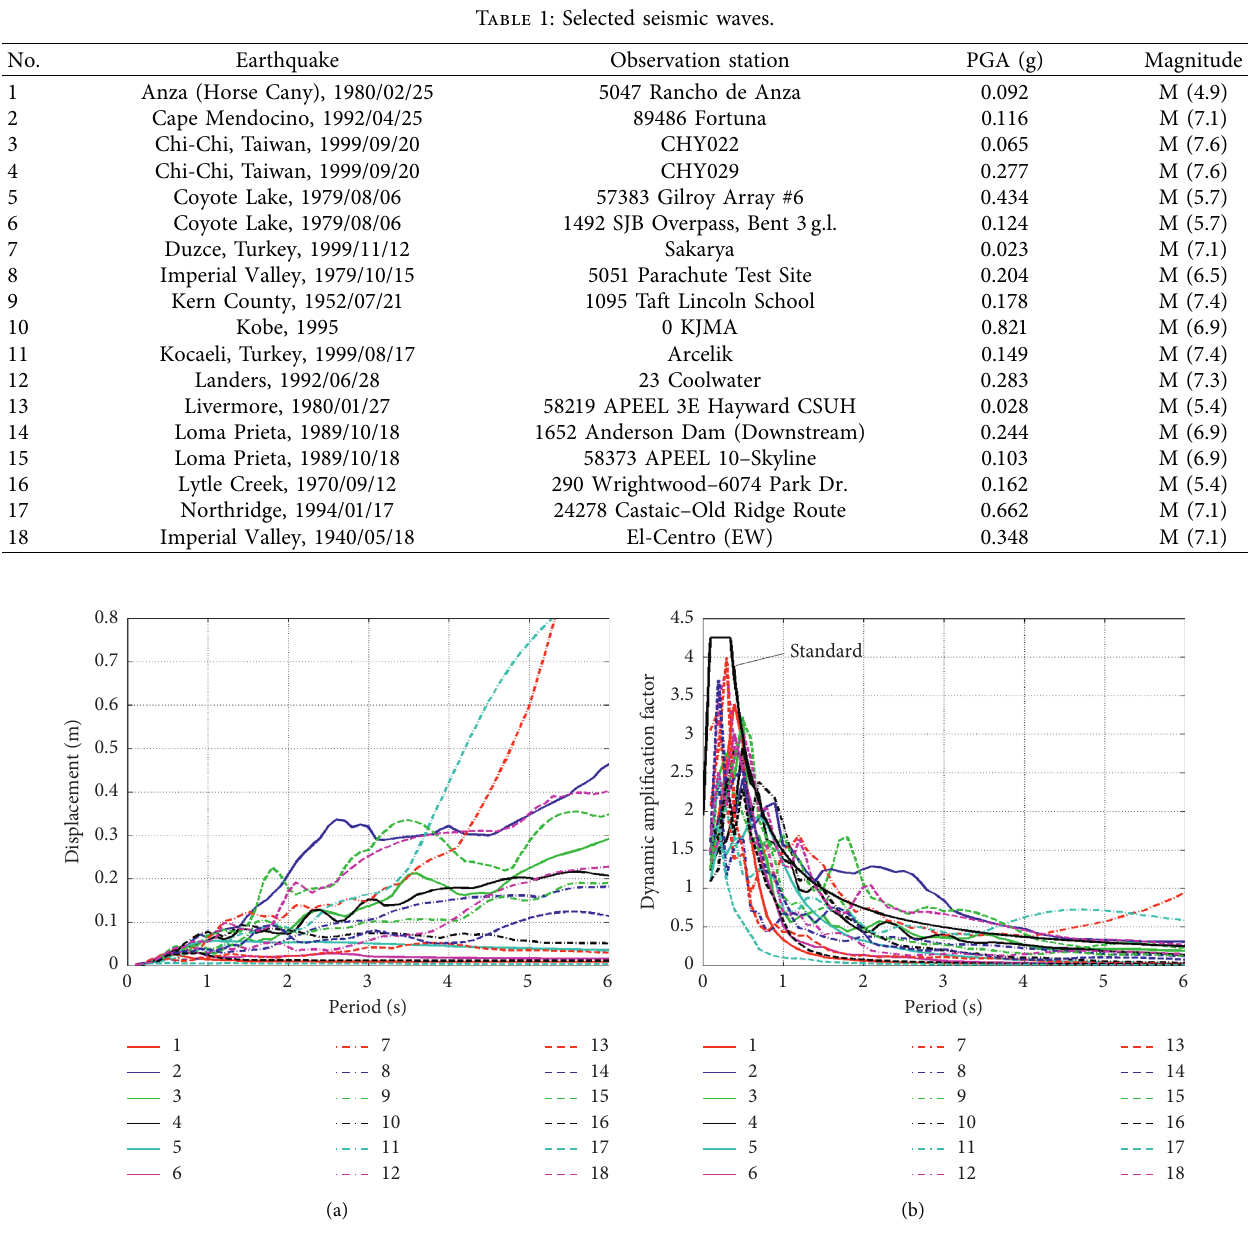
Figure 9: Analytical results without considering pounding. (a) Displacement spectrum. (b) Dynamic amplification factor